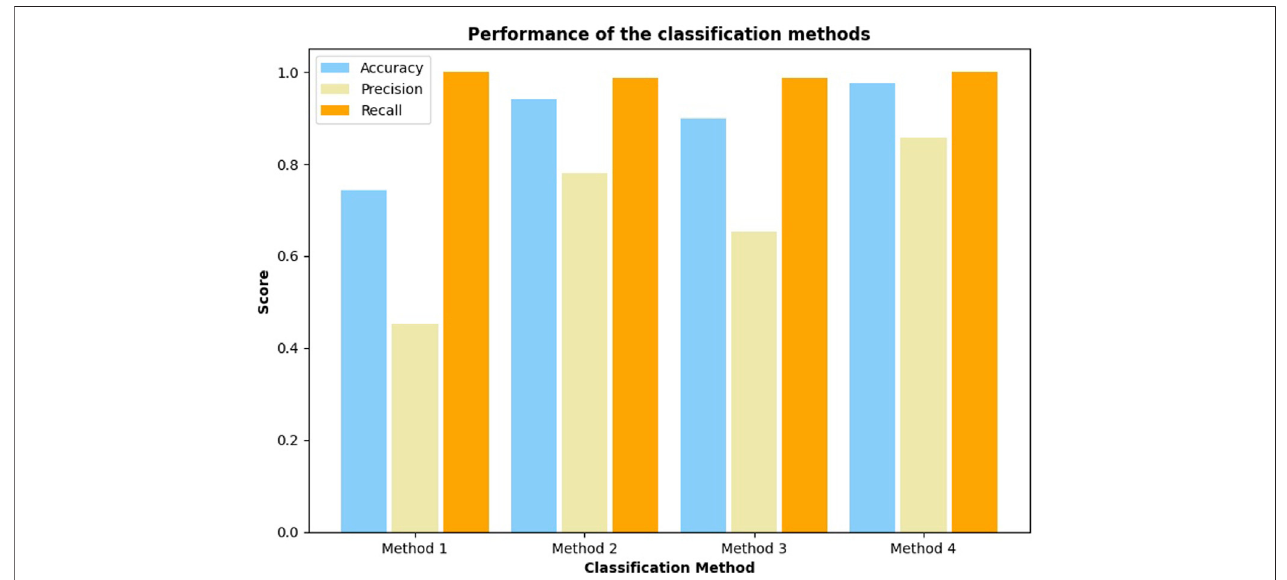
FIGURE 12 | The fi gure shows accuracy, precision and recall, averaged across all dishes. Precision is the main parameter that improves with more information provided.